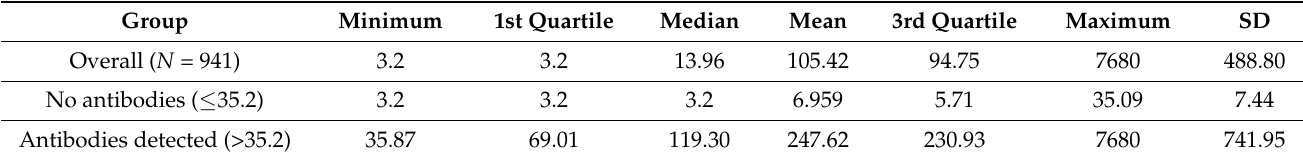
Table 4. Descriptive statistics for healthy unvaccinated